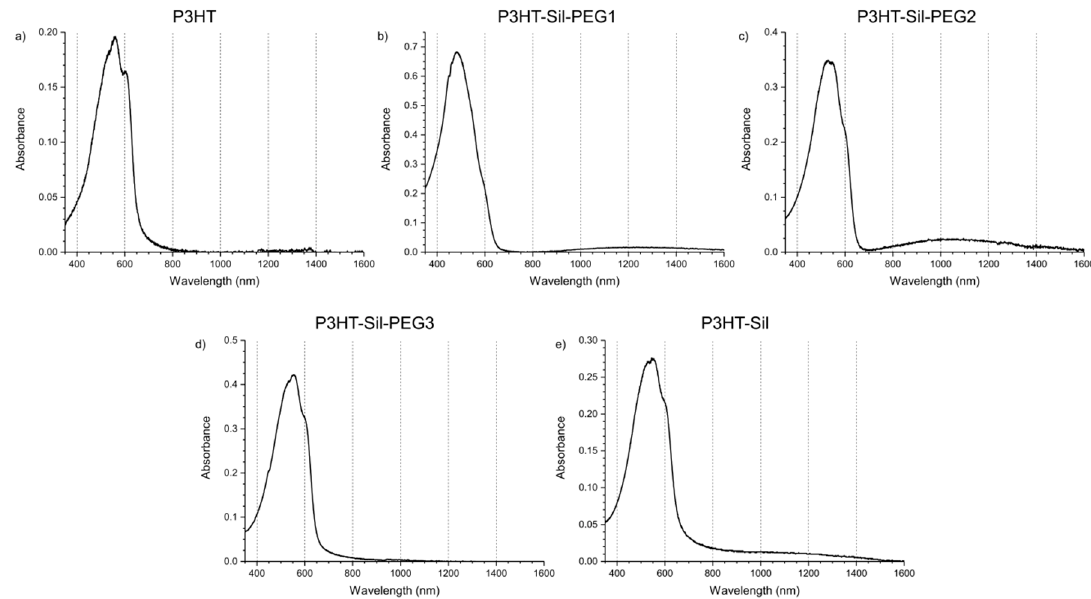
Figure 6. UV-Vis-NIR spectra (corrected for supporting electrolyte absorption) of investigated polymer films of ( a ) regioregular P3HT; ( b ) P3HT-Sil-PEG1; ( c ) P3HT-Sil-PEG2; ( d ) P3HT-Sil-PEG3; ( e ) P3HT-Sil in a solution of 0.1M tetrabutylammonium hexafluorophosphate in acetonitrile, at open